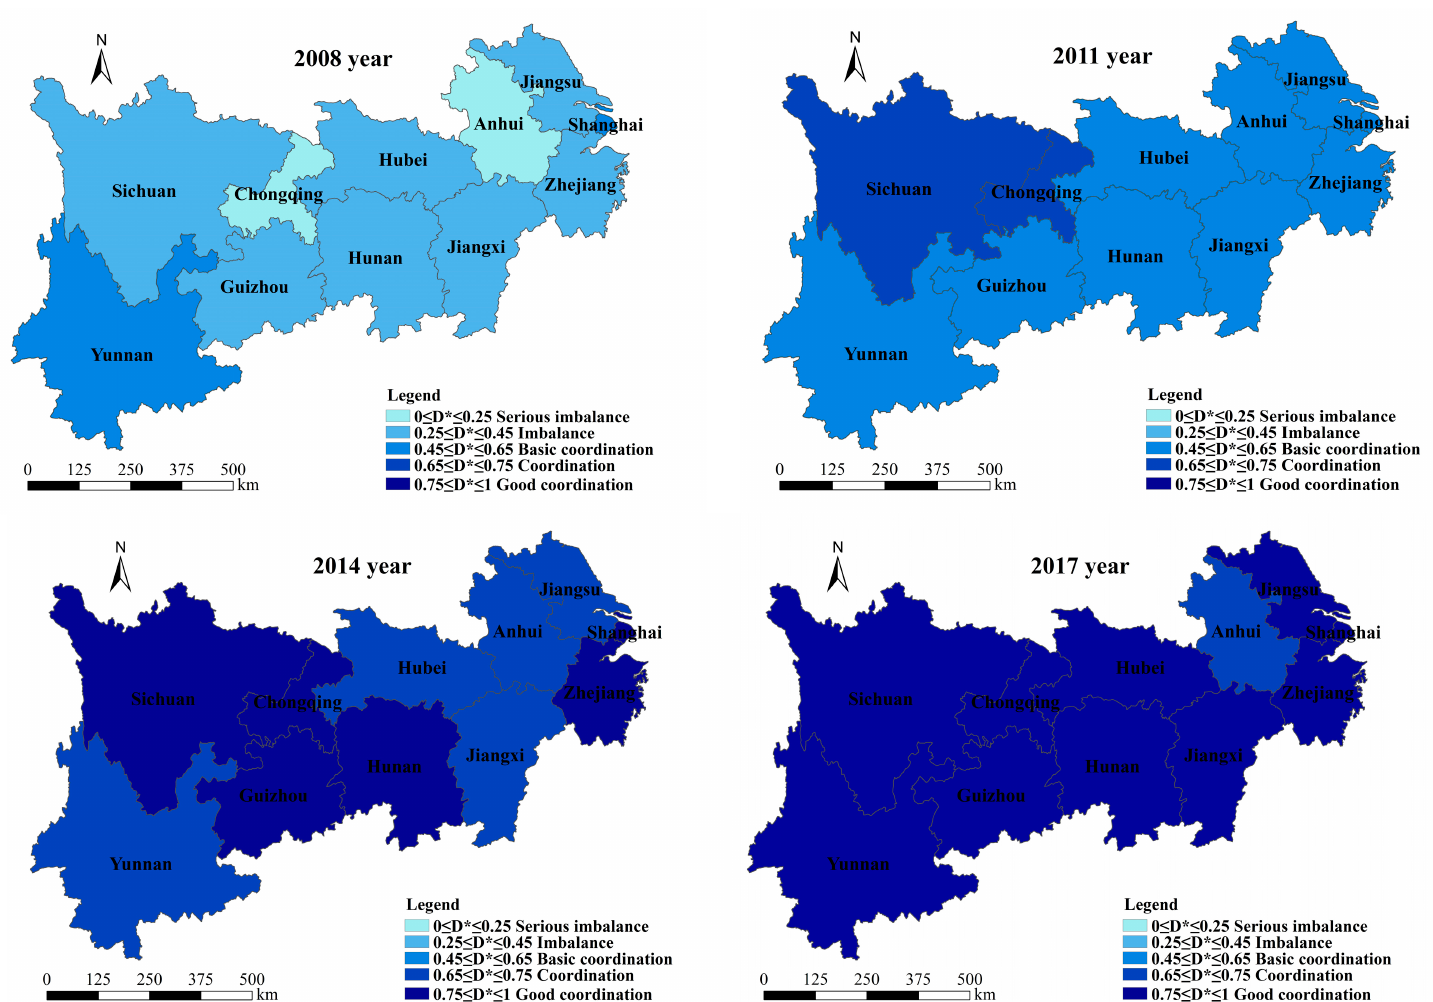
Figure 6. Spatial distribution of coordination state in the YREB. .